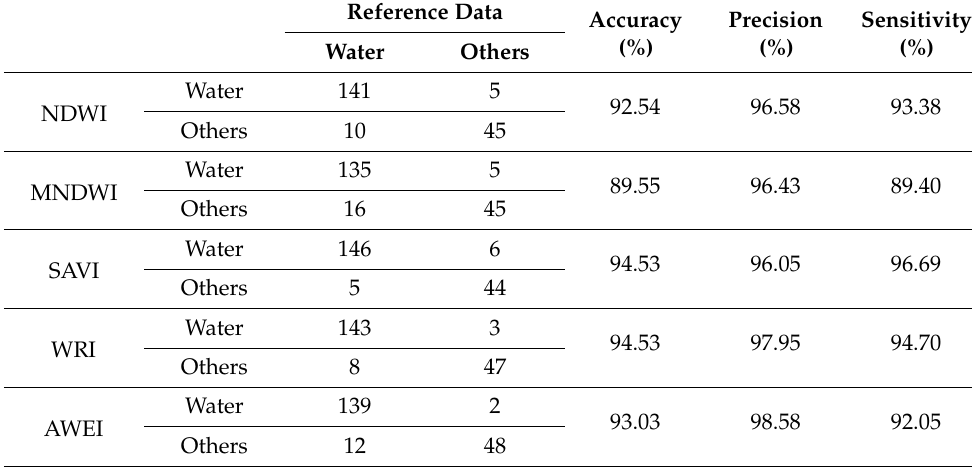
Table 4. Confusion matrix of the results obtained from water indices in